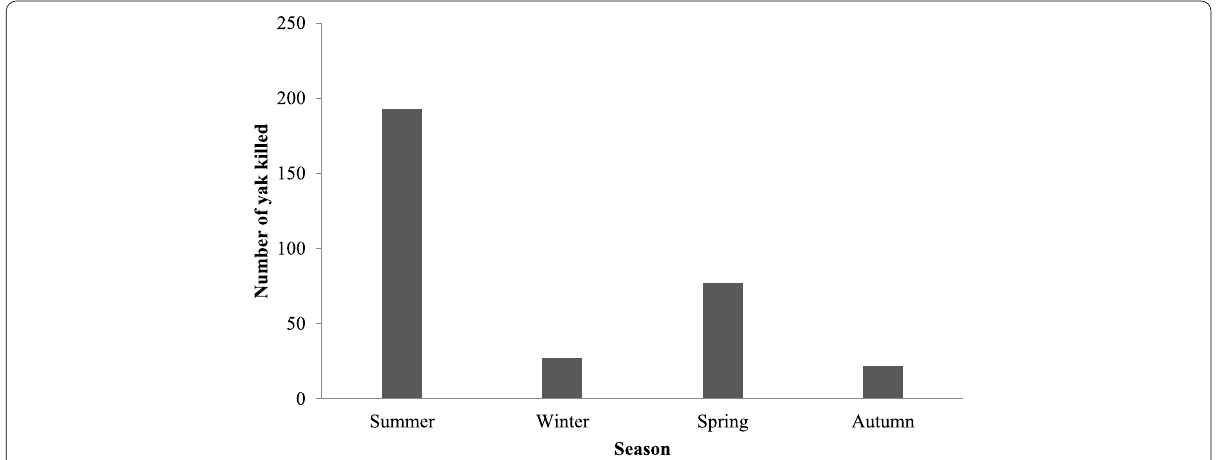
Fig. 4 Seasonal preference of yak depredation by snow leopard